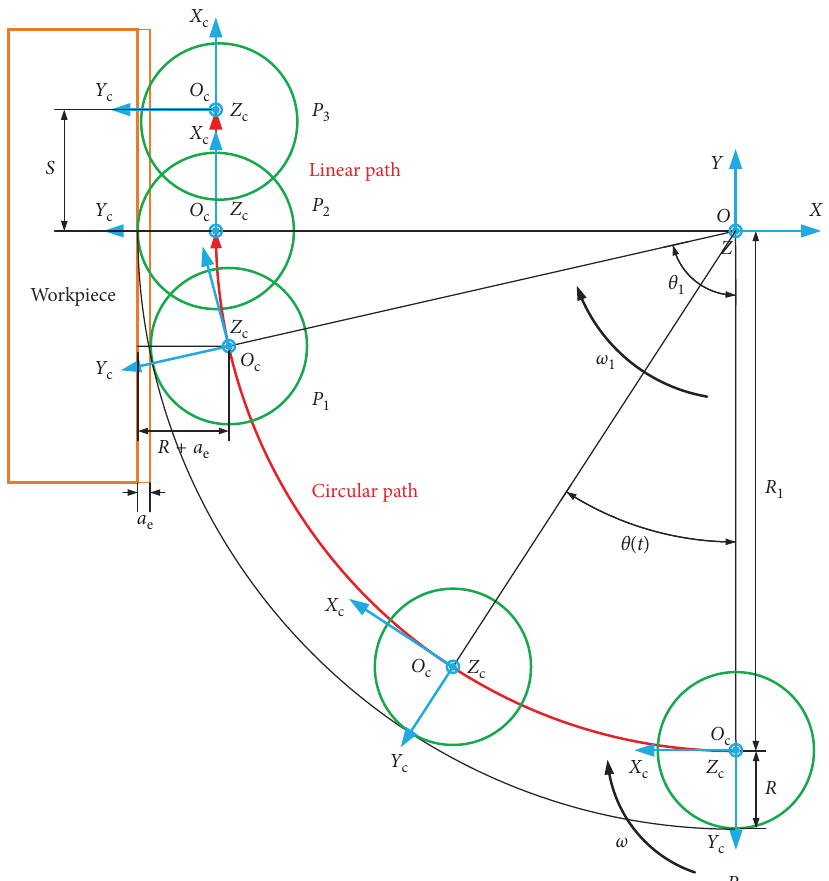
Figure 9: Cutter entering workpiece along a circular path.